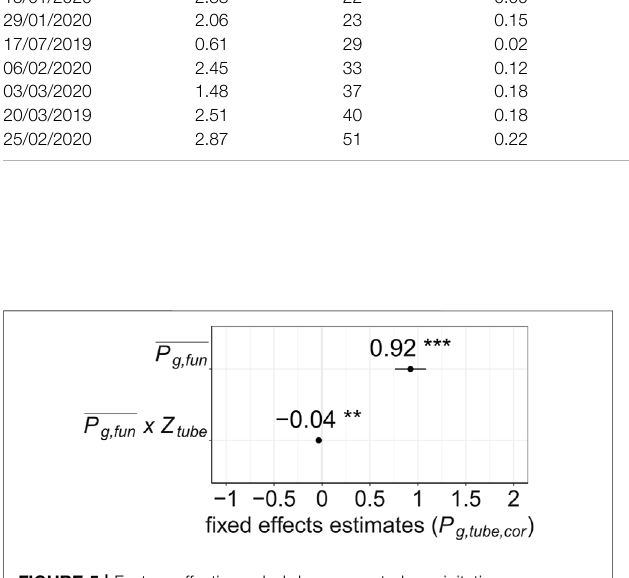
FIGURE 5 | Factors affecting splash loss corrected precipitation measurement with the tubes (P g , tube corrected ) during the uncovered period. Values on the x -axis indicate the slope of the relations. Signi fi cant predictors are: weekly measured mean gross precipitation ( P g , fun ) and elevation of interception tubes ’ locations (Z tube ). All variables were scaled with Z transformation. Interactions are shown with ‘ x ’ Signi fi cance code *** is 0, ** is 0.001.